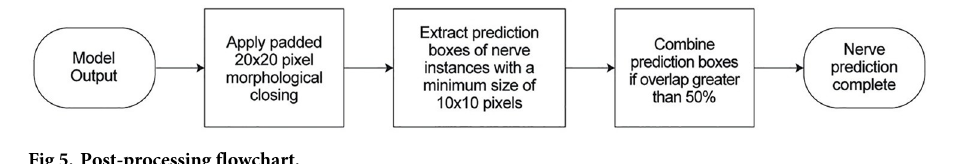
Fig 5. Post-processing